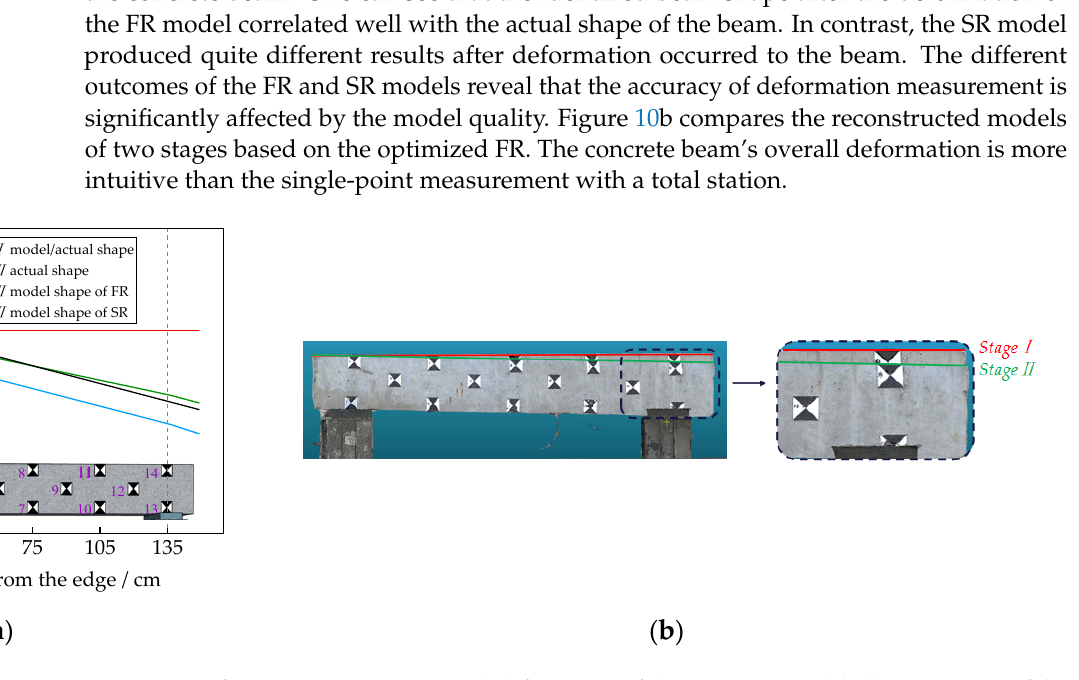
Figure 10. Deformation measurement: ( a ) deformation of the two-stage model; ( b ) comparison of the two-stages models of FR.